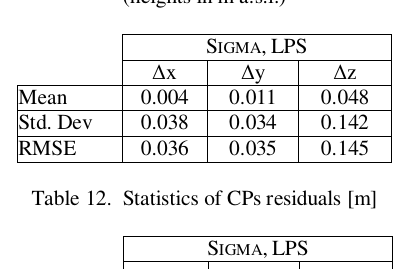
Figure 11. DSM with encircled wrong interpolations (heights in m a.s.l.)